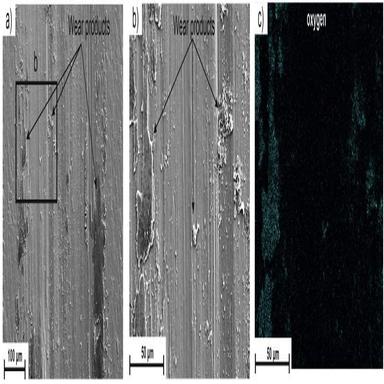
(a) SEM image of one of the wear tracks, where wear products are clearly visible. (b) Higher-magnification image of region b marked in (a), and (c) EDS map of the oxygen content in (b).